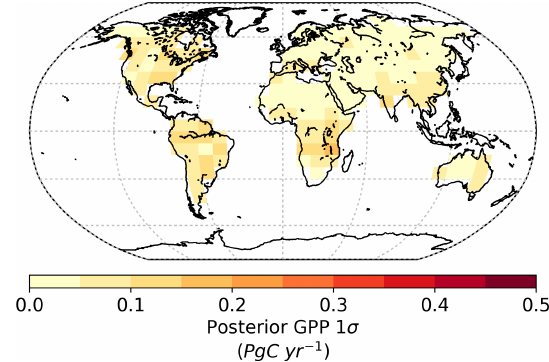
Figure 5. Posterior parametric uncertainty in annual GPP.